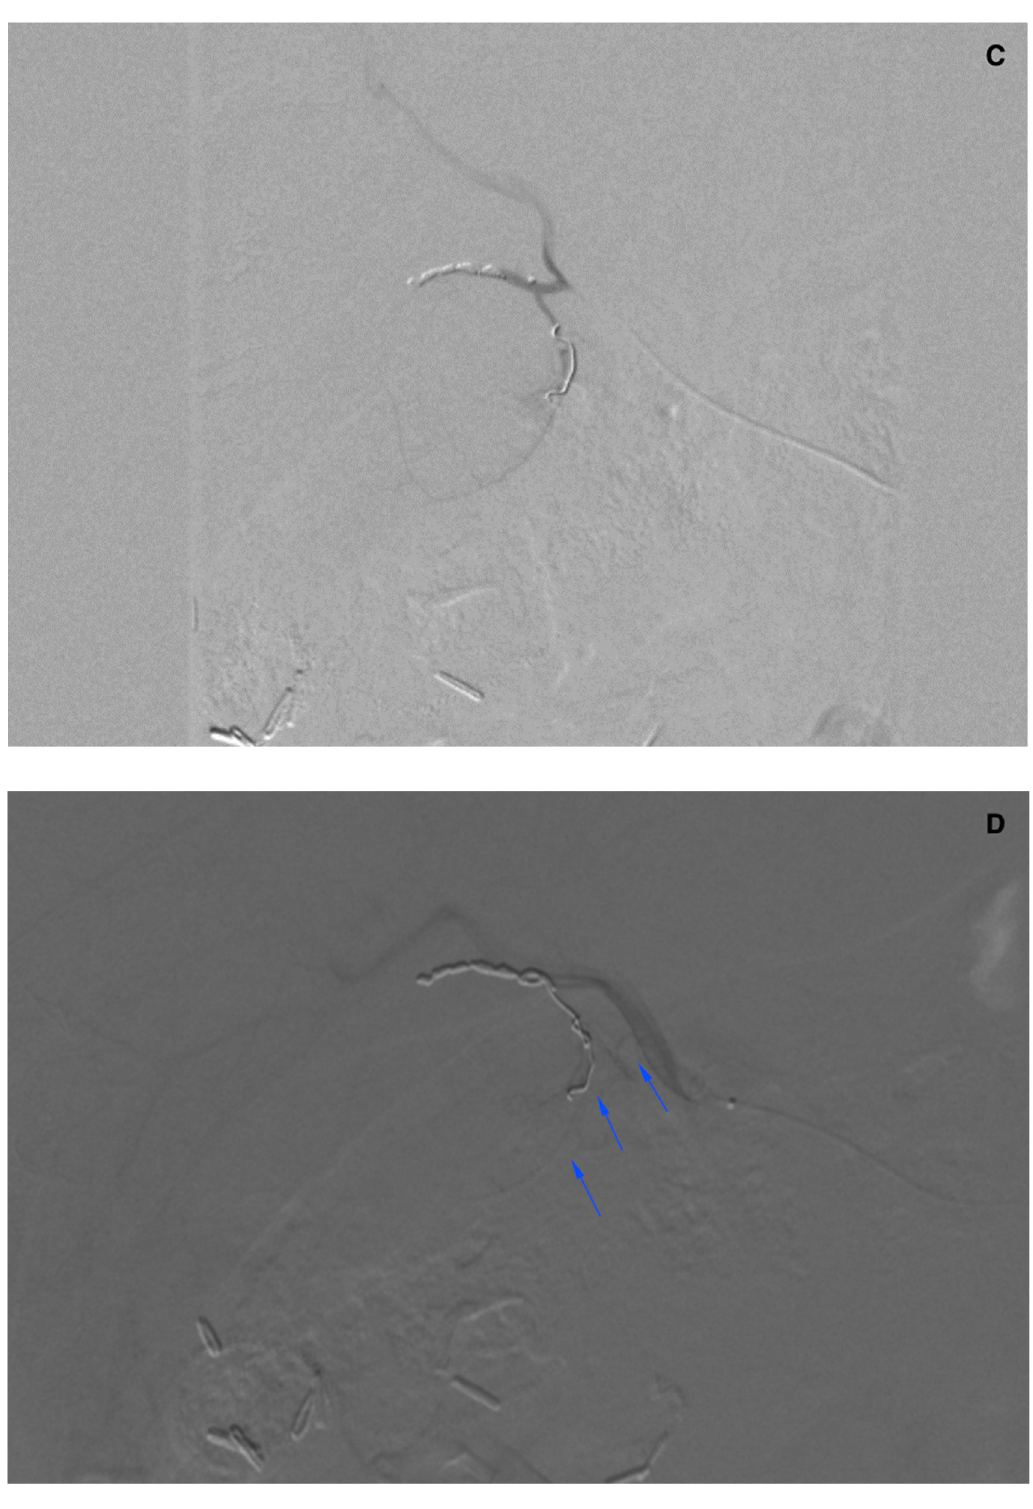
Figure 3. Angiogram of the right hepatic artery. ( A ) Initially, single CA is visible (arrows) originating from the right hepatic artery division. ( B ) After embolization, another artery reveals multiple intrahepatic anastomoses to the gallbladder wall, and needs to be embolized. ( C ) There is insufficient embolization of both CA, and ( D ) retraction of the microcatheter reveals another CA originating proximally to the right hepatic artery division (arrows).